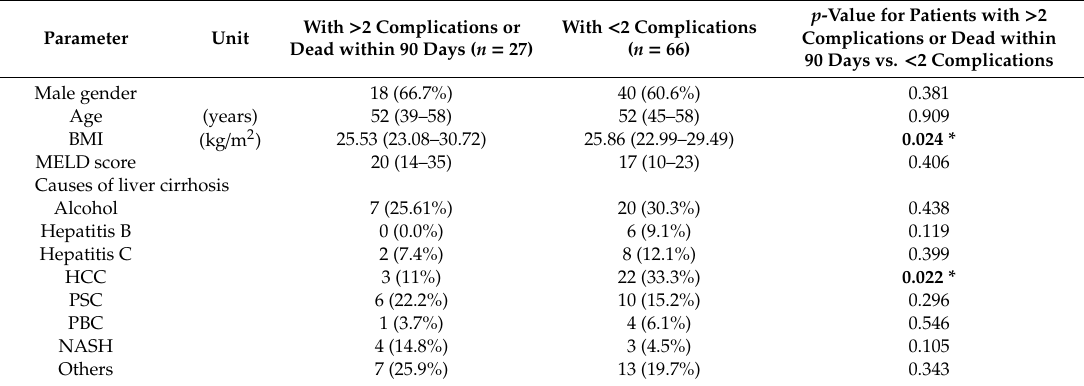
Table 2. Baseline Demographic Data of Complication